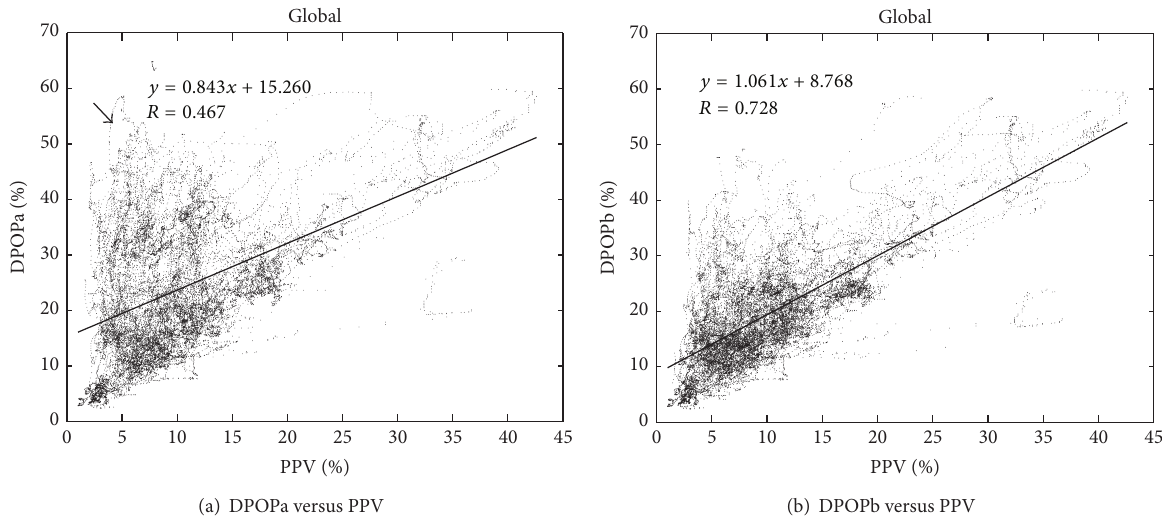
Figure 4: Original and PMod corrected DPOP results for global regions. Note: vertical axes are set to the same scale across plots.